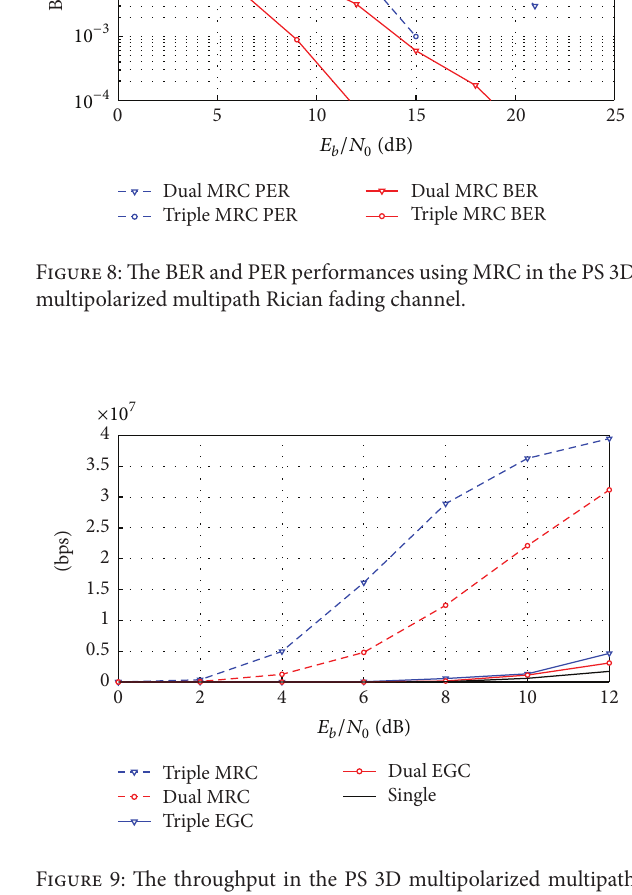
Figure 9: The throughput in the PS 3D multipolarized multipath Rician fading